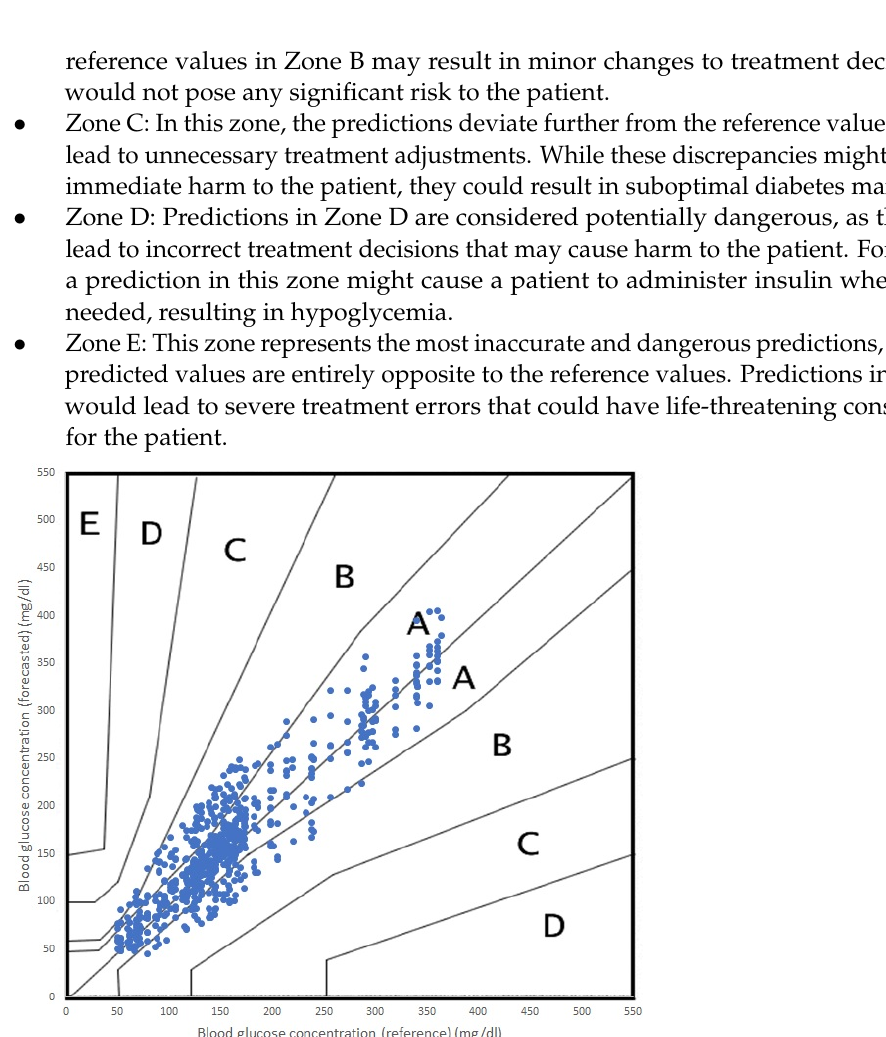
Figure 5. Parkes error grid for RF predictions, PH 45 min.